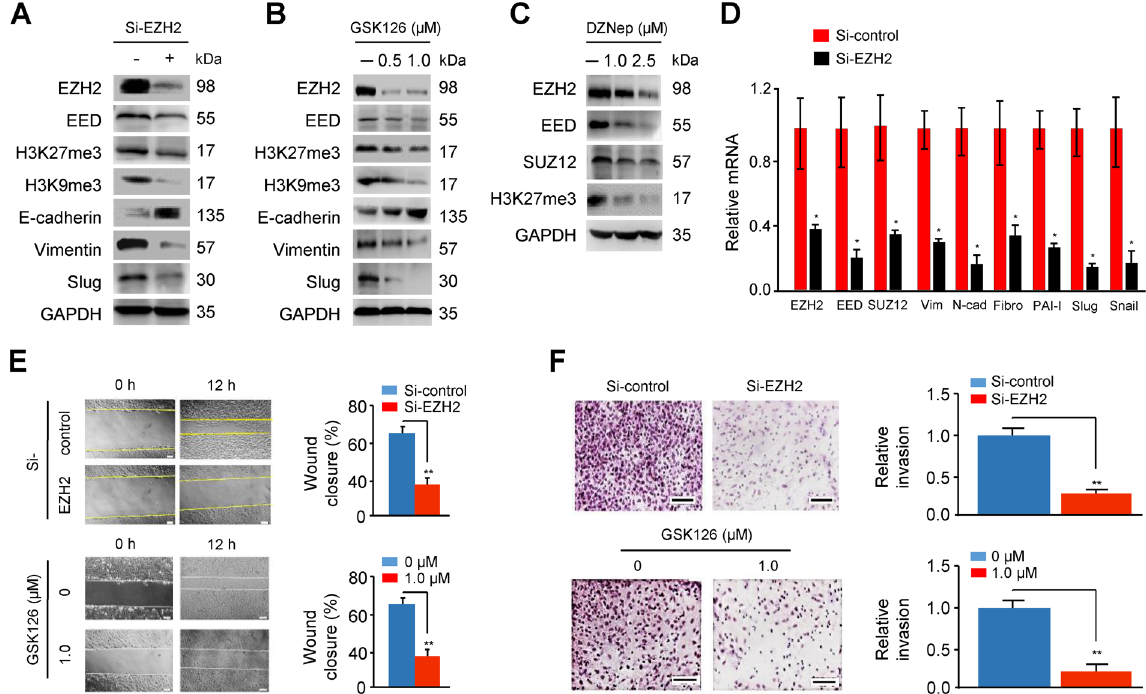
Figure 2. EZH2 promotes EMT in endometriotic epithelial cells. ( A–C ) Western blotting analysis of the indicated proteins in 11Z cells following EZH2 knockdown (n = 5) ( A ), or the treatment with GSK126 (n = 5) ( B ) or DZNep (n = 5) ( C ). The cropped blots are used in the figure. The membranes were cut prior to exposure so that only the portion of gel containing desired bands would be visualized, as described in materials and methods. ( D ) qPCR analysis of the indicated genes in 11Z cells following EZH2 knockdown (n = 5). ( E , F ) Migratory ( E ) and invasive ( F ) capacity of 11Z cells following EZH2 knockdown (upper panel) or the treatment with GSK126 (lower panel), was evaluated using wound healing assay and invasion assay (n = 4 each), respectively. Vim, Vimentin; N-cad, N-cadherin; Fibro, Fibronectin. * P < 0.05; ** P <